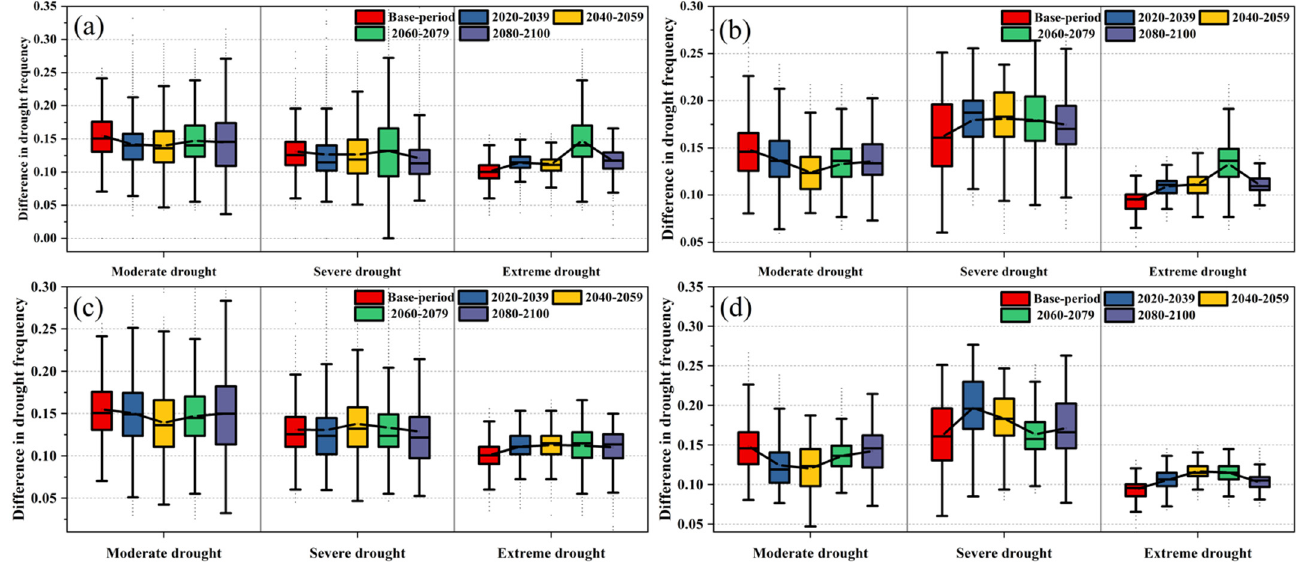
Figure 10. Frequency variation in different drought levels in the NCP ( a ) and LP ( b ) under the RCP4.5 scenario. Frequency variation in different drought levels in the NCP ( c ) and LP ( d ) under the RCP8.5 scenario.